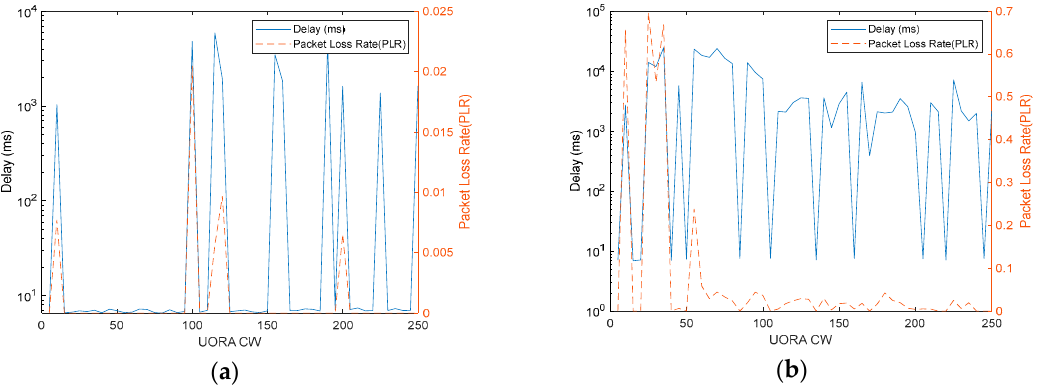
Figure 17. Average delay and PLR in two bands transmission over UORA congestion window (CW) value: ( a ) Below user capacity threshold (190 STAs); ( b ) Below user capacity threshold (200 STAs).